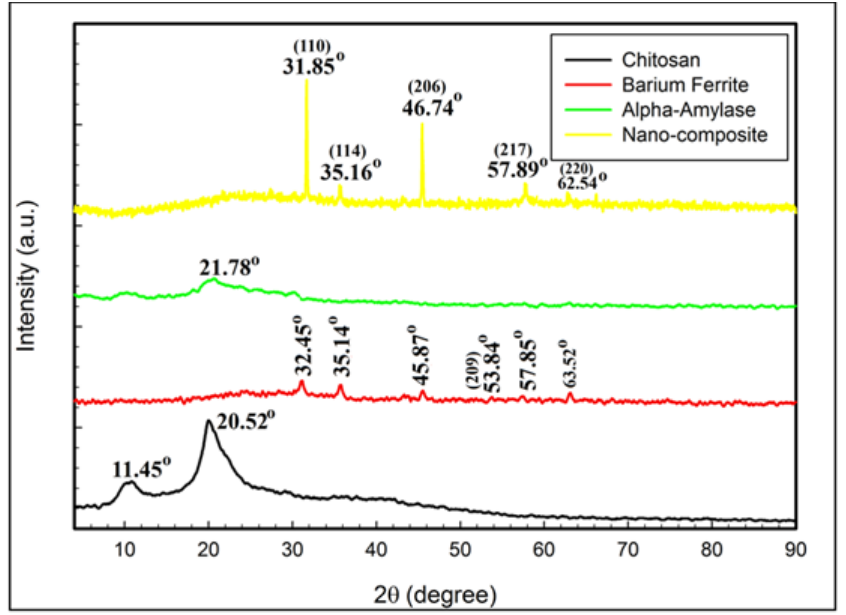
Figure 4. XRD patterns of chitosan at 11.45° and 20.52°; barium ferrite at 32.45°, 35.14°, 45.87°, 53.84°, 57.85°, and 63.52°, accounting for the Bragg reflections at (110), (114), (206), (209), (217), and (220), respectively; alpha-amylase at 21.78°; and synthesized alpha-amylase-BFCMNPs at 31.85°, 35.16°, 46.74°, 57.89°, and 62.54°, which describe the Bragg reflections at (110), (114), (206), (217), and (220), respectively.